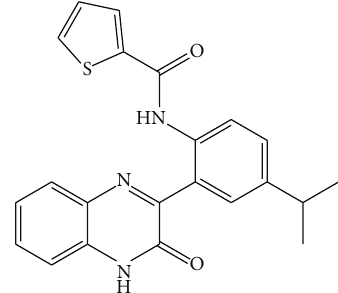
Figure 32: Chemical structure of compound 80 .